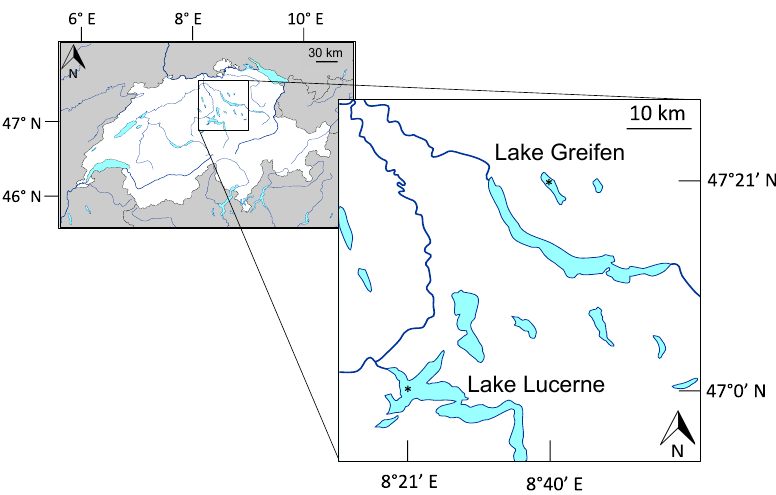
Figure 1. Map of Switzerland with locations of Lake Greifen and Lake Lucerne indicated. Base map from d-maps (http://www.d-maps.com/